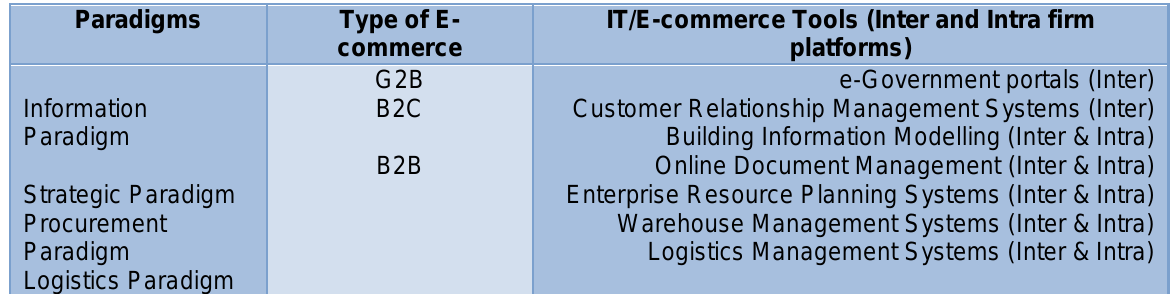
Table 3 E-commerce in construction internationalisation of construction business Primarily, contracting firms can exploit international markets by sensing and seizing opportunities offered by the e-commerce pl atform and reconfigure the firms’ resources to (a) outsource business functions or operations to an international destination (upstream activities) and/or (b) offer the firm’s products or services in the international market (downstream activities). The successful usage of e-commerce to support internationalisation is not without challenges. The asymmetry in e-commerce distribution seems to be caused not only by various levels of economic and socio-technical infrastructure, political and legal factors but also by cultural aspects in adopting e-commerce across nations. These have been recognised as major issues in the internationalisation of e-commerce (Kshetri, 2001). E-commerce can only be utilised competently at an optimum level if the employees and all clients have good ability to make use of the technology (Johnson and Whang, 2002). Thus, e-commerce platform